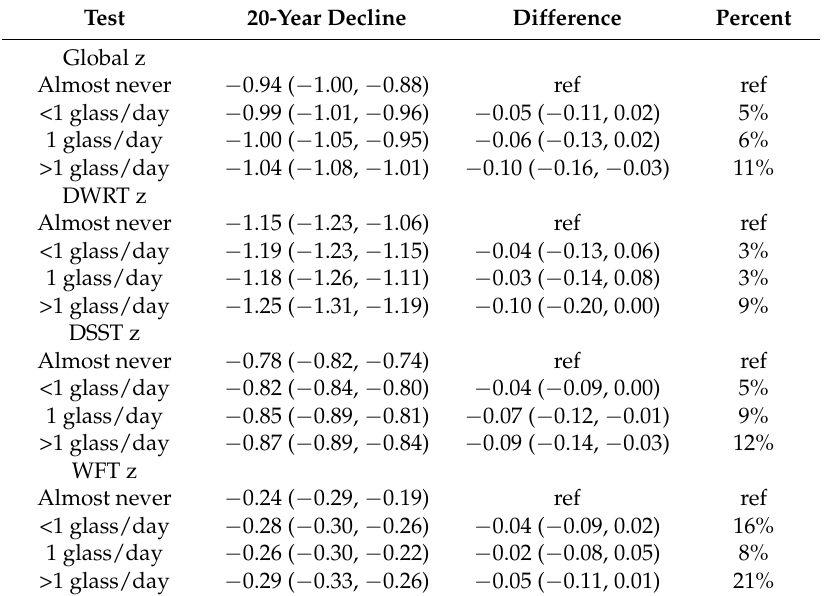
Table 2. Estimated, adjusted * race-specific difference in the 20-year change in cognitive performance by milk intake category. ARIC Study.